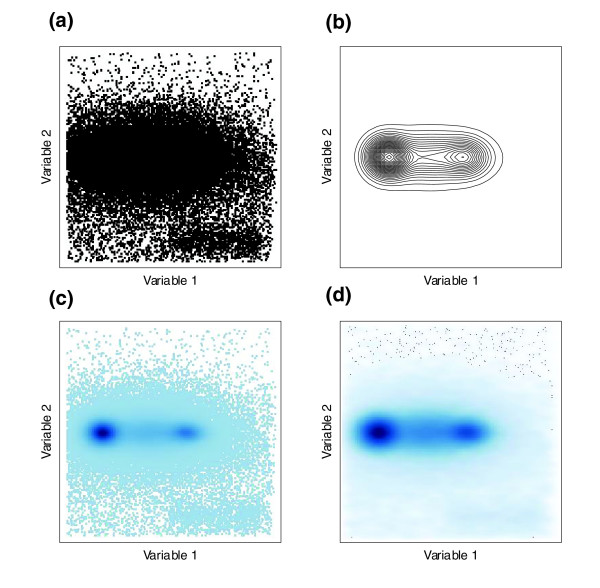
Options to create plots with high point densities. (a) Almost no features of the data distribution are visible in the simple scatter plot. (b) The contour plot reveals the bimodality of the data. (c) Coloring of points according to point density and (d) density map with additional points in sparse regions.